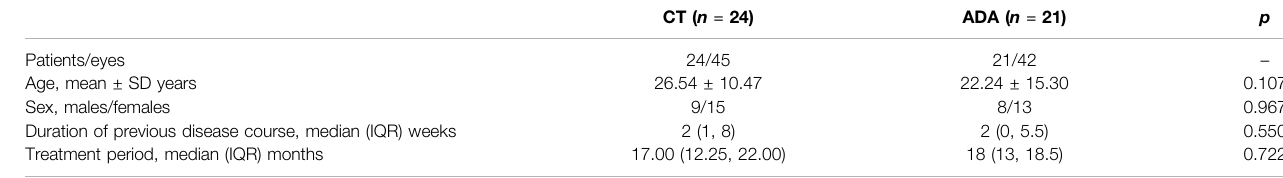
TABLE 1 | Demographic characteristics of 45 treatment-naïve patients with BU with retinal vasculitis who received ADA or conventional therapeutic regimen.